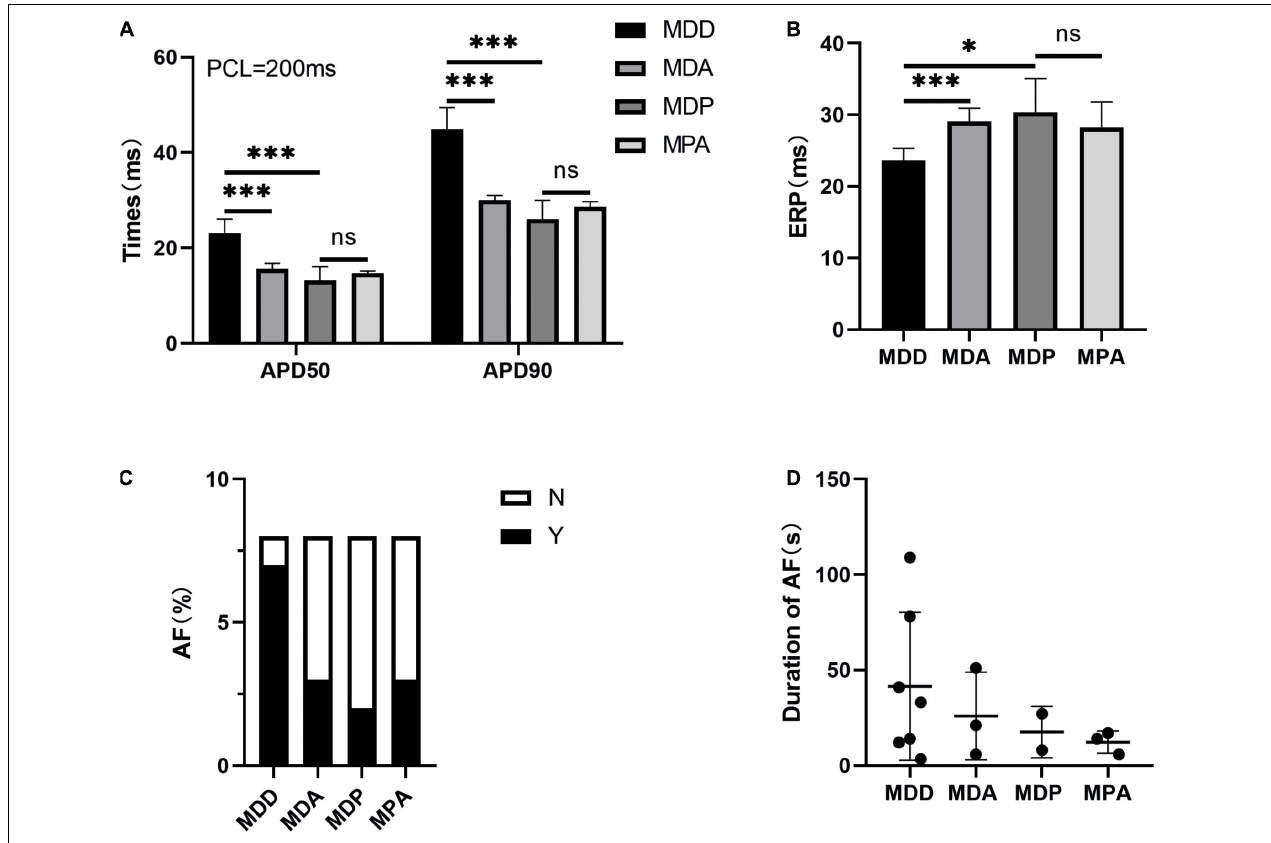
FIGURE 14 | Atrial electrophysiological parameters. (A) APD 50 and APD 90 at a PCL of 200 ms. (B) Average ERP. (C,D) Inducibility and duration of AFs. n = 8 per group. * p < 0.05, *** p < 0.001 vs. MDD; ns, no significance.